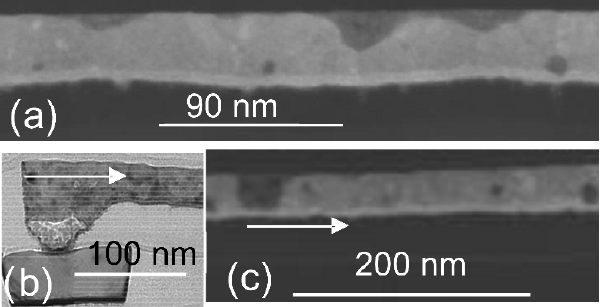
Figure 1. Transmission Electron Microscope (TEM) images of Cu lines and via, including the EM- induced via void and line voids. ( a ) is an unstressed sample of Cu line with Cu fill voids and surface gouges. ( b ) is the via after EM stress with EM-induced voids. ( c ) is the M1 (metal 1) line after stress with EM-induced voids. The arrows show directions of electron flows. Reprinted with permission from ref. [6]. Copyright 2018, IEEE.